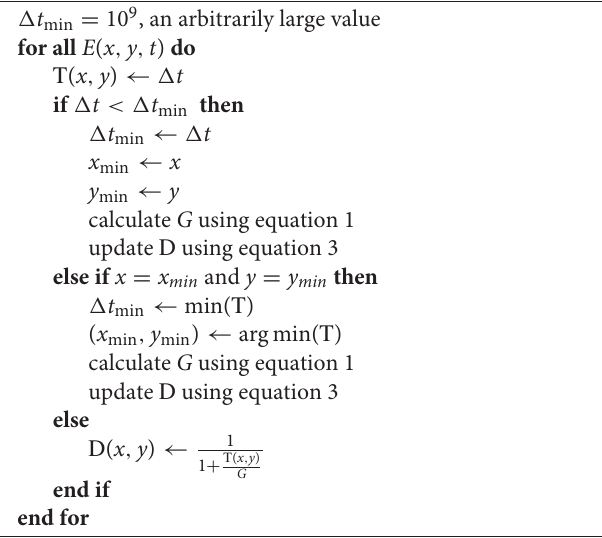
Algorithm 1 Global event-based tone